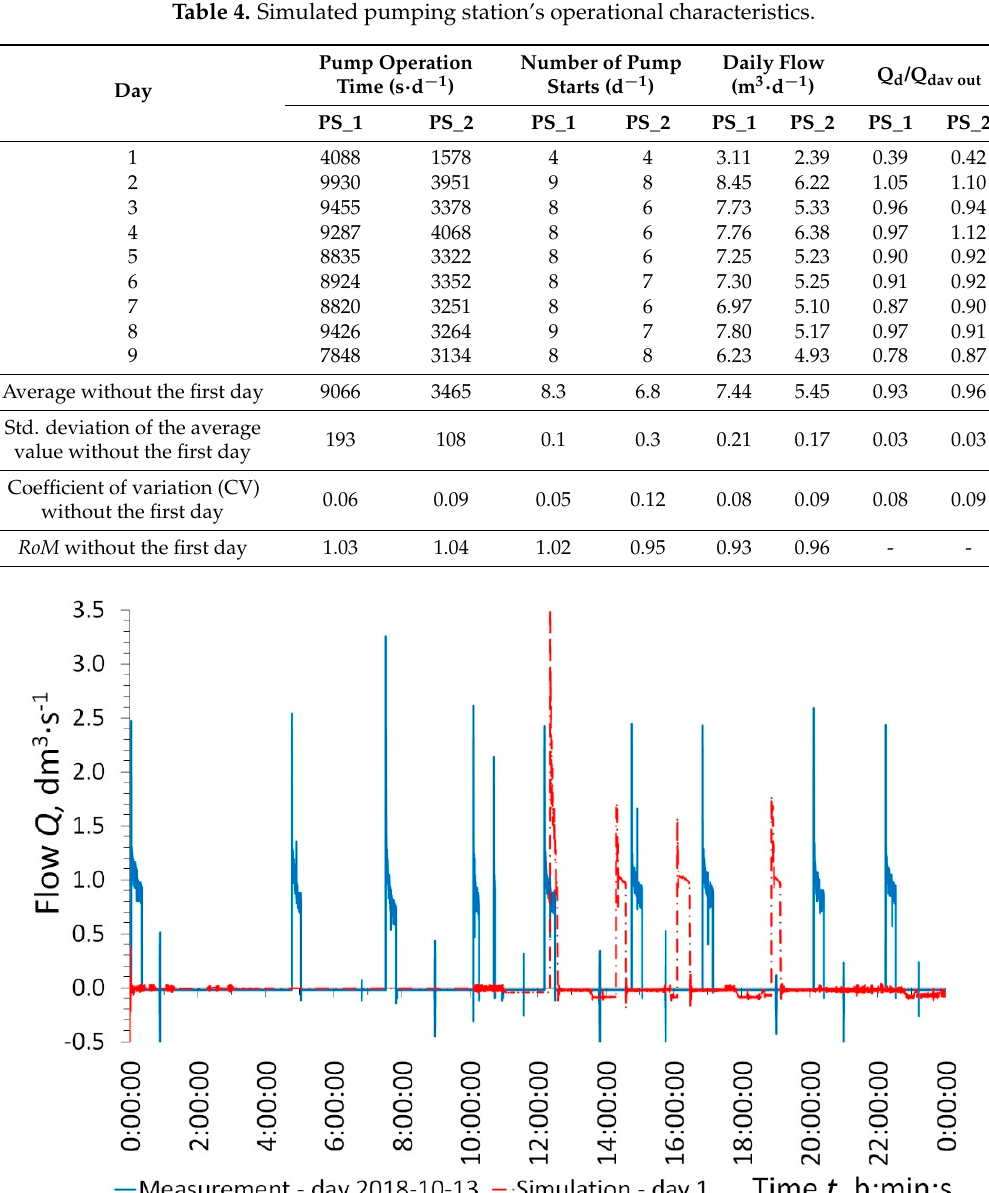
Figure 11. Flows in force main measured on 13 October 2016 and simulated for day 1 using the SWMM 5.1 program.